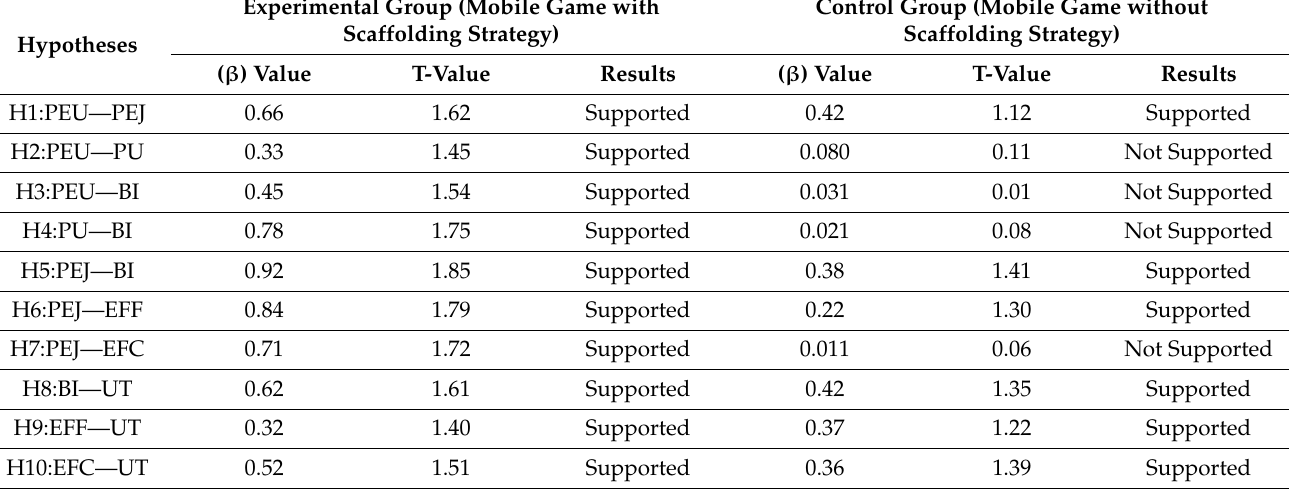
Table 1. Structural Model Analysis